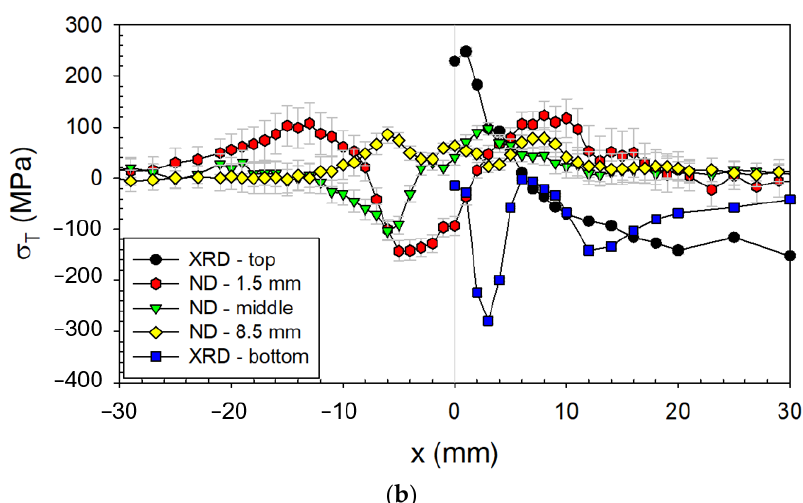
Figure 5. ( a , b ) Residual stresses RS (analyzed by XRD and ND) depending on the distance from the weld axis .